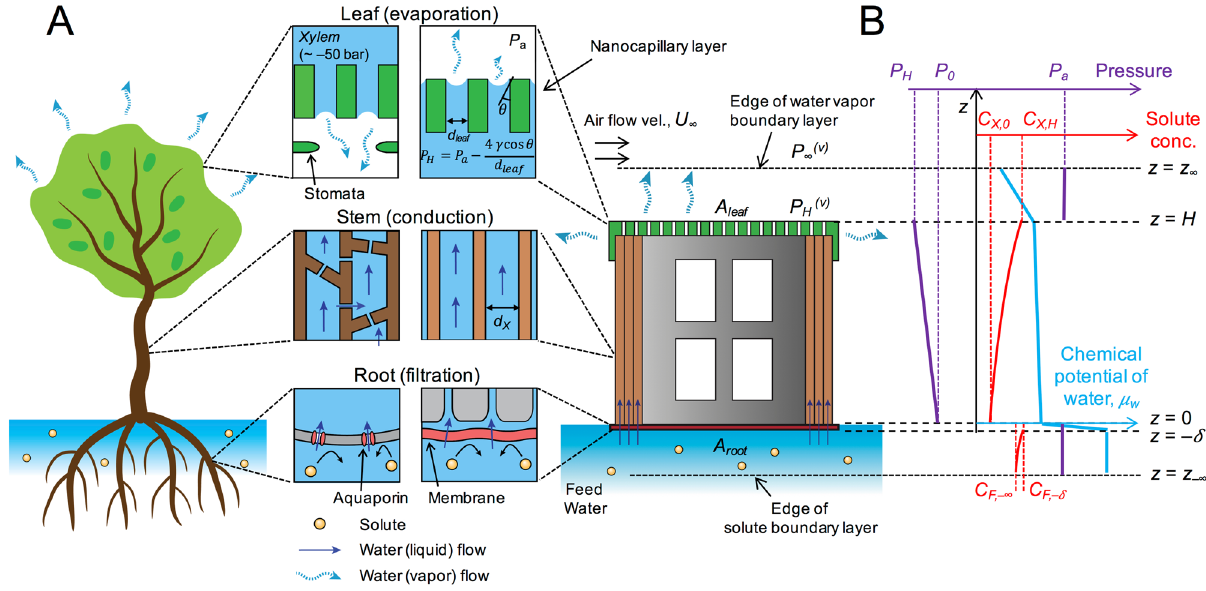
Figure 1. Overview of dewatering process by an artificial tree. ( A ) Schematic illustrations of a natural mangrove tree and an artificial tree for dewatering process, and their similarities in functions: filtration (root), conduction (stem), and evaporation (leaf) of water. ( B ) Distributions of chemical potential of water, pressure, and solute concentration through the artificial tree at different